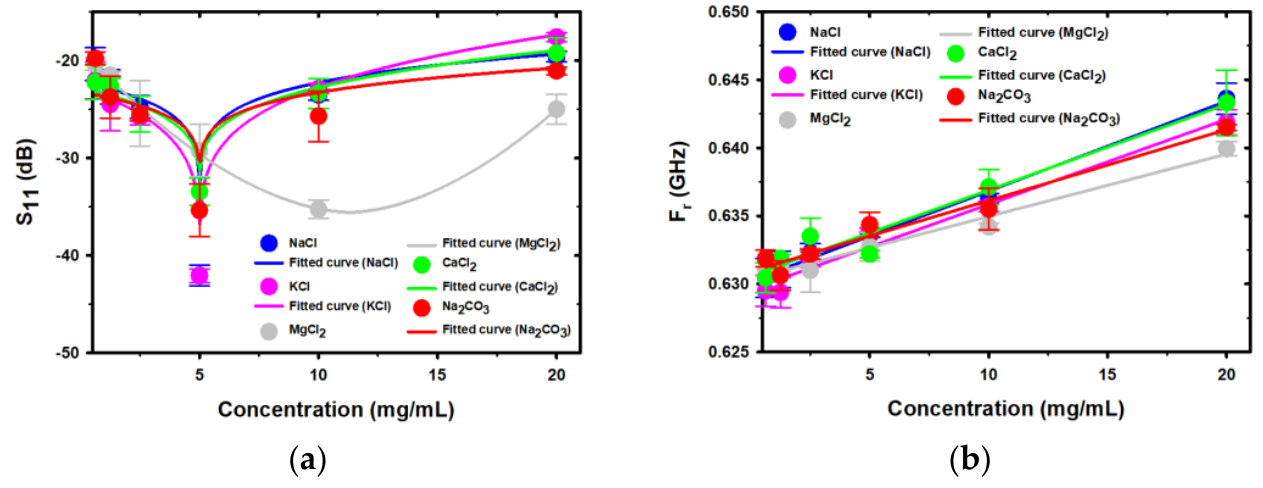
Figure 8. The relationship between the concentration of salt in water in the frequency range of the second resonance peak and the resulting values of ( a ) S 11 and ( b ) F r .